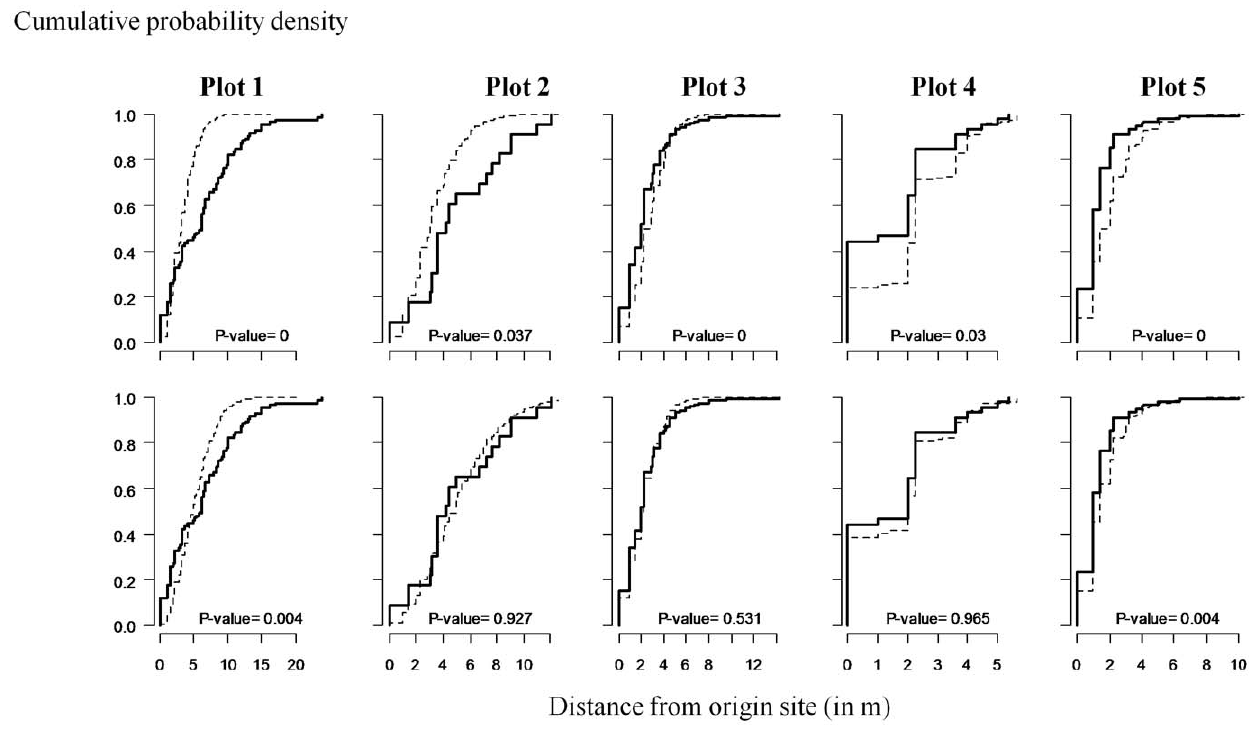
Figure 3. Dispersal distances in the five bananas plots (observed versus simulated by POM). Simulations were driven for habitat- dependent and habitat-independent models with the respective maximum likelihood estimates. Cumulative distribution plot of simulated distances (dashed line) versus observed distances (bold line) from (a) the habitat-independent model and (b) the habitat-dependent model. P-values correspond to the results of the Kolmogorov-Smirnov test of equal distributions for observed and simulated dispersal distances (based on . 100 simulations).